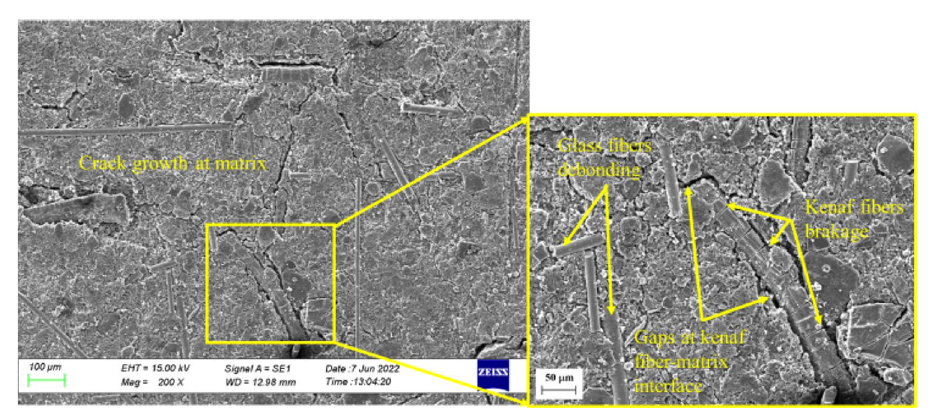
Figure 10. Scanning electron micrographs of the surface of the MCC0 composite post-immersion in distilled